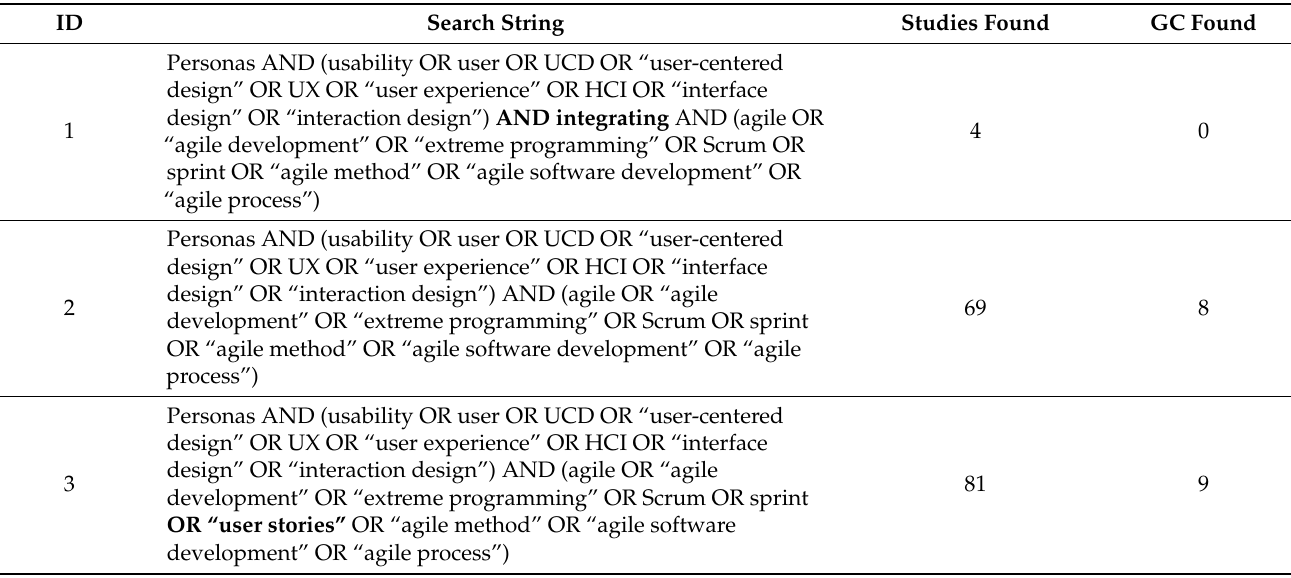
Table 2. Search strings.